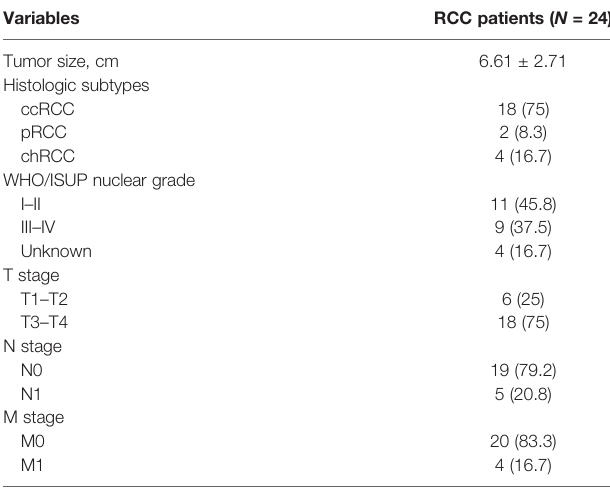
TABLE 2 | The pathological data of patients with